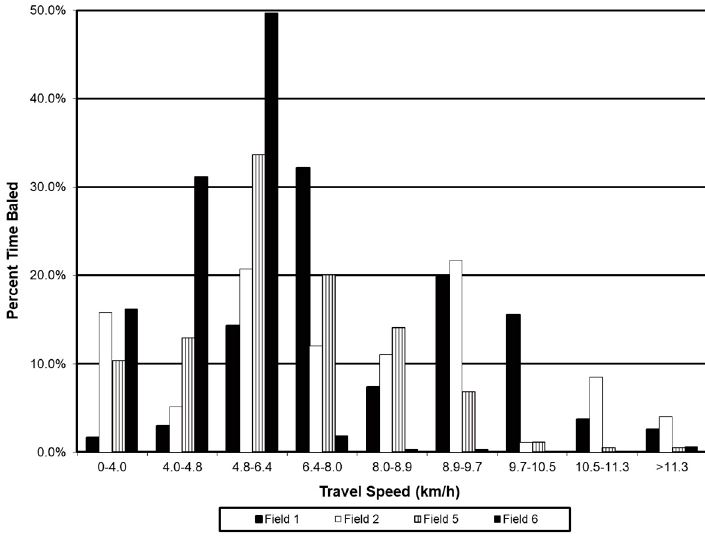
Figure 3. The frequency distribution of baler speed in Fields 1, 2, 5 and 6.